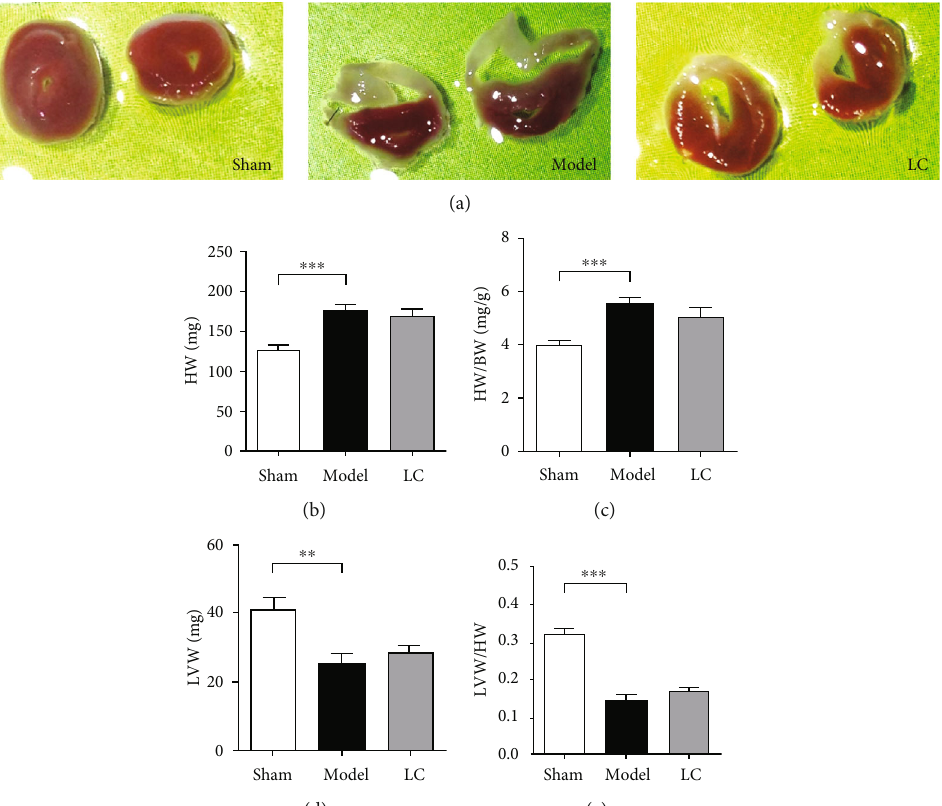
Figure 2: LC reduced the post-MI infarct size. (a) Representative images of TTC staining of cardiac sections from mice. TTC-negative staining area represented for infarct myocardium, while TTC-positive staining area referred to the myocardium that were not a ff ected. (b) Heart weight. (c) The ratio of heart weight to whole body weight. (d) Left ventricular weight. (e) Ratio of left ventricular weight to heart weight. Data were expressed as means ± SEM . n = 5 ; ∗∗ p < 0 : 01 , ∗∗∗ p < 0 : 001 , compared to the sham